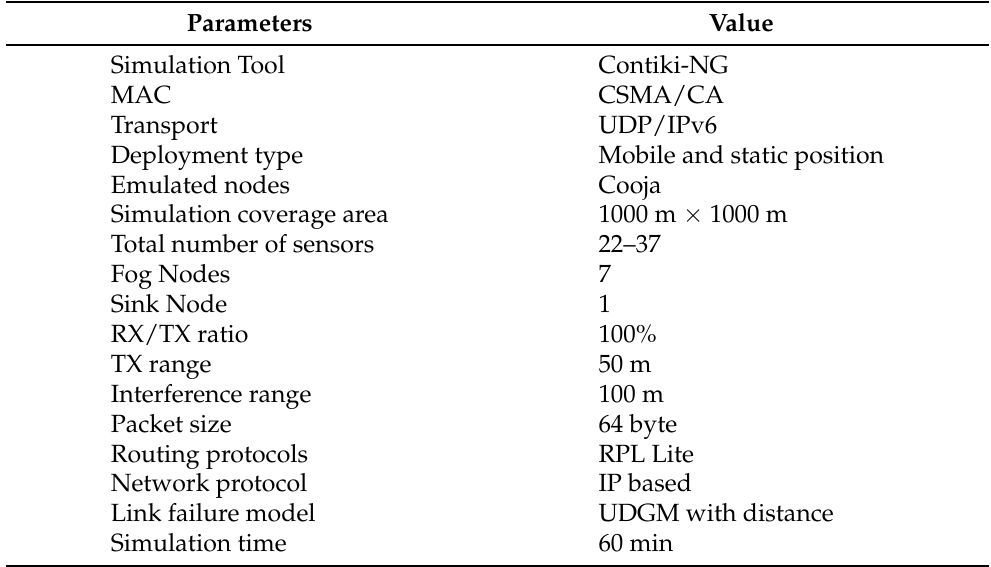
Table 2. Parameter